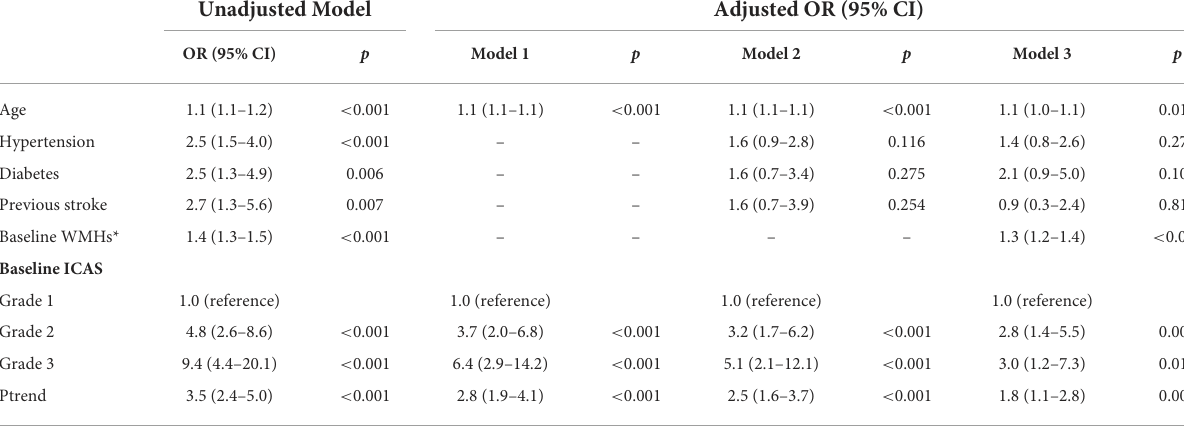
TABLE 2 Logistic regression analysis of baseline ICAS severity with risk of WMHs progression.